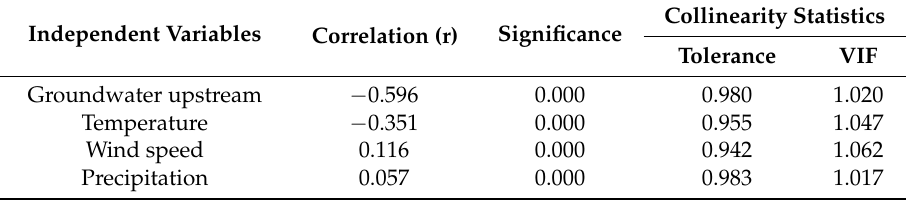
Table 1. The correlation coefficient (r) was determined between the raw water discharge and the predictor variables in the MLR model. The significance level is reported for each predictor